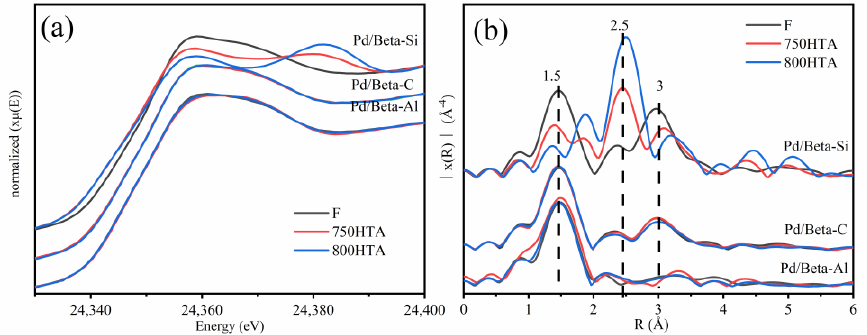
Figure 7. ( a ) Pd K-edge XANES spectra and ( b ) Fourier transforms of the k3-weighted Pd K-edge EXAFS of Pd1/Beta.